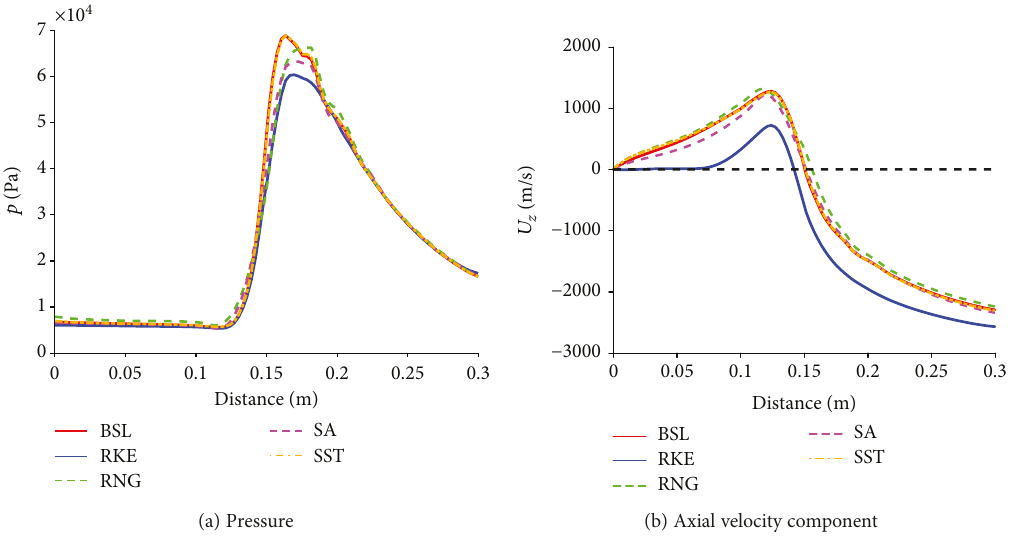
Figure 6: Pressure and axial velocity component distribution along the rocket center axis from the bottom.